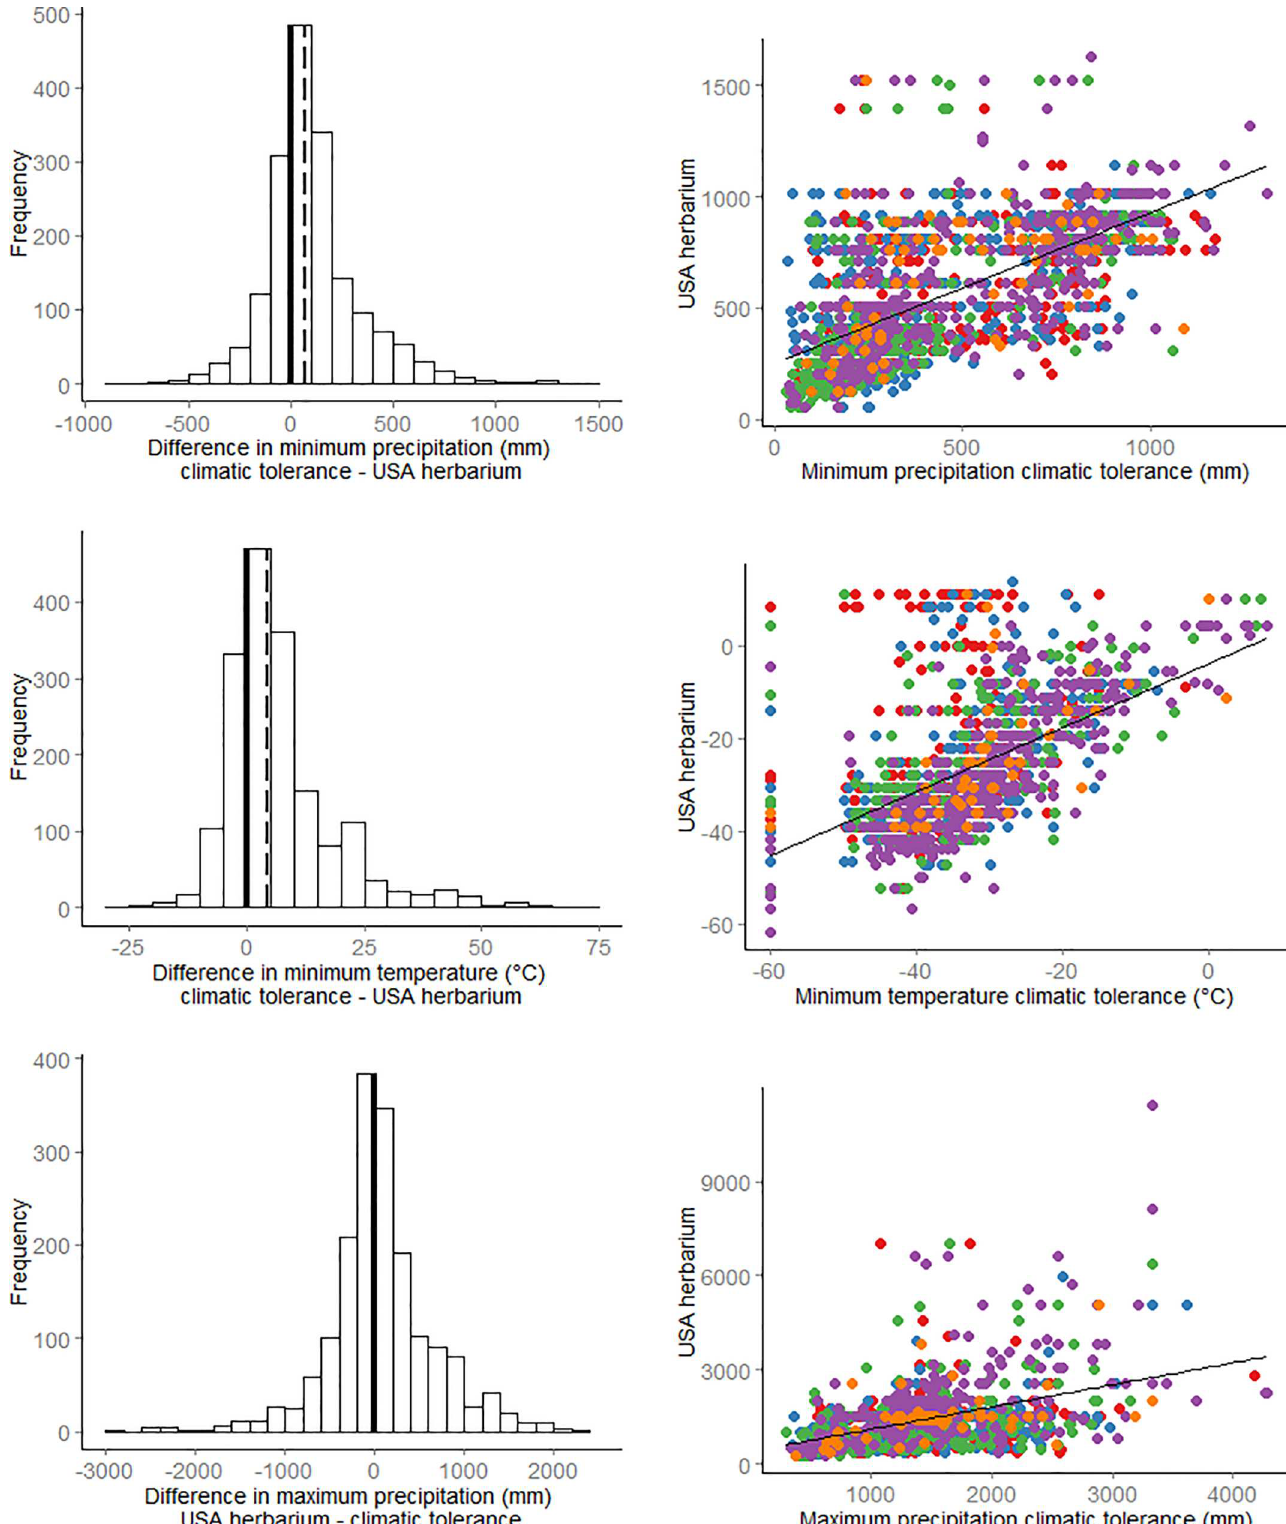
Fig 1. Frequency distributions of comparative niche values ( Δ CN). For all climate variables, herbariumrecords from GBIF tend to estimate broaderclimatic niches than climatic tolerance estimates. (A-C) Histogram values to the right of zero (solid line) indicatespecies with broader climatic